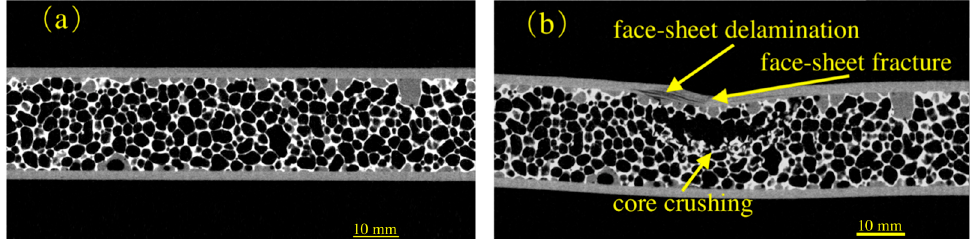
Figure 9. Tomographic images of #20-0.37: ( a ) before deformation; ( b ) after deformation.